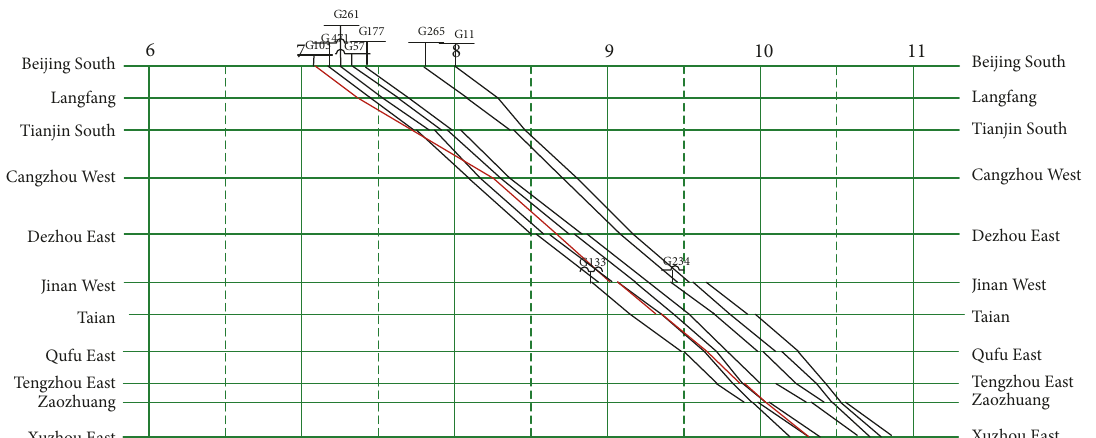
Figure 8. The trend of the delay time of trains G103, G261, G57, G177, and G11 gradually decreases in Figure 8. The delay time of each train at each station is shown in Figure 9. The delay time at the Cangzhou West Station and Dezhou East Station during the train operation by the adjustment